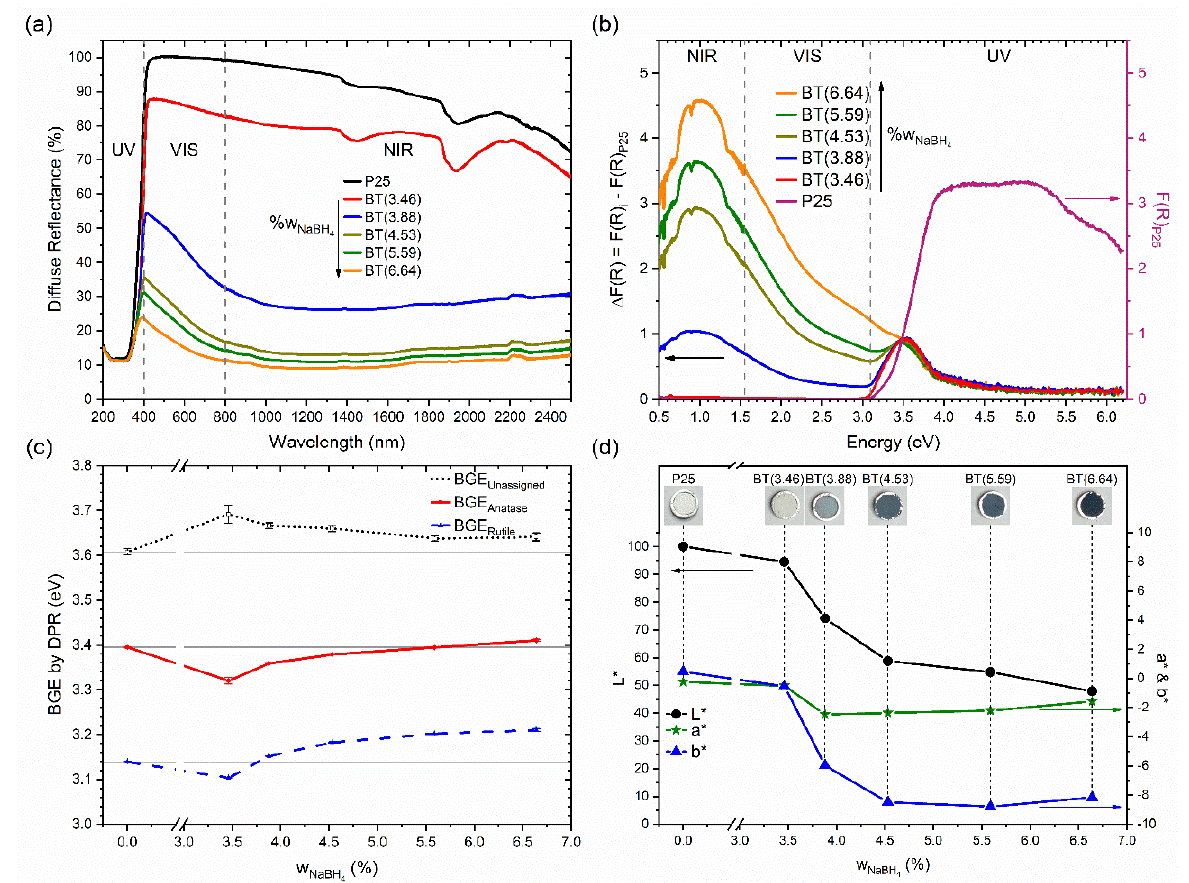
Figure 4. ( a ) Reflectance spectra of the prepared samples. ( b ) Spectra subtracted from P25 spectrum. ( c ) Values of the bandgap energies estimated by the DPR method. ( d ) Colorimetric parameters of the samples in the CIE L*a*b* system. Inset shows photographs of the samples.